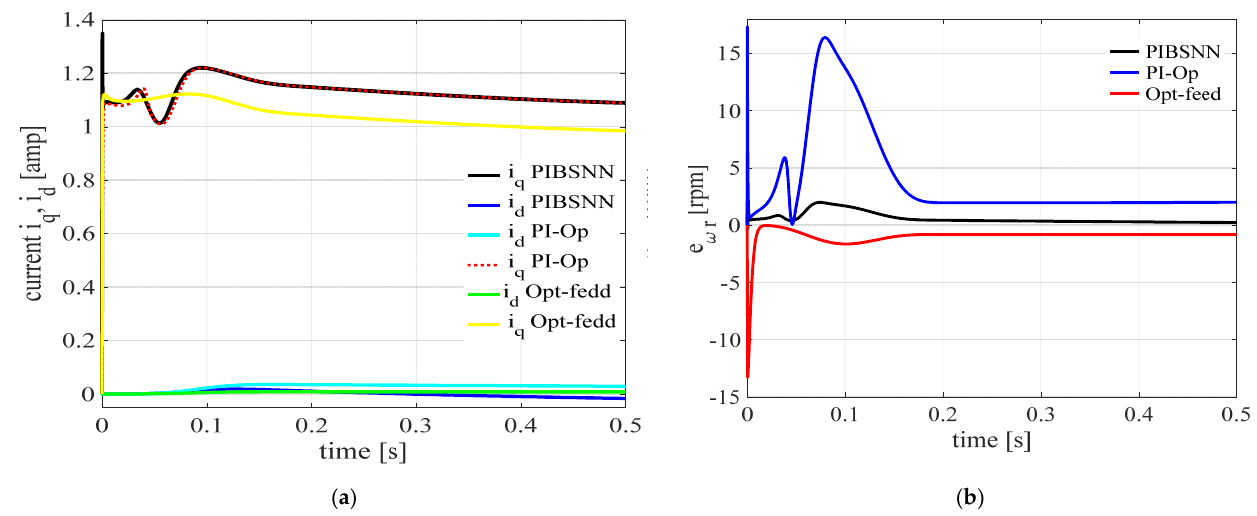
Figure 8. Transient response of the PMSM for case 1 ( a ) dq axis current and ( b ) speed tracking error. Table 3. Speed error performance indices for case 1.